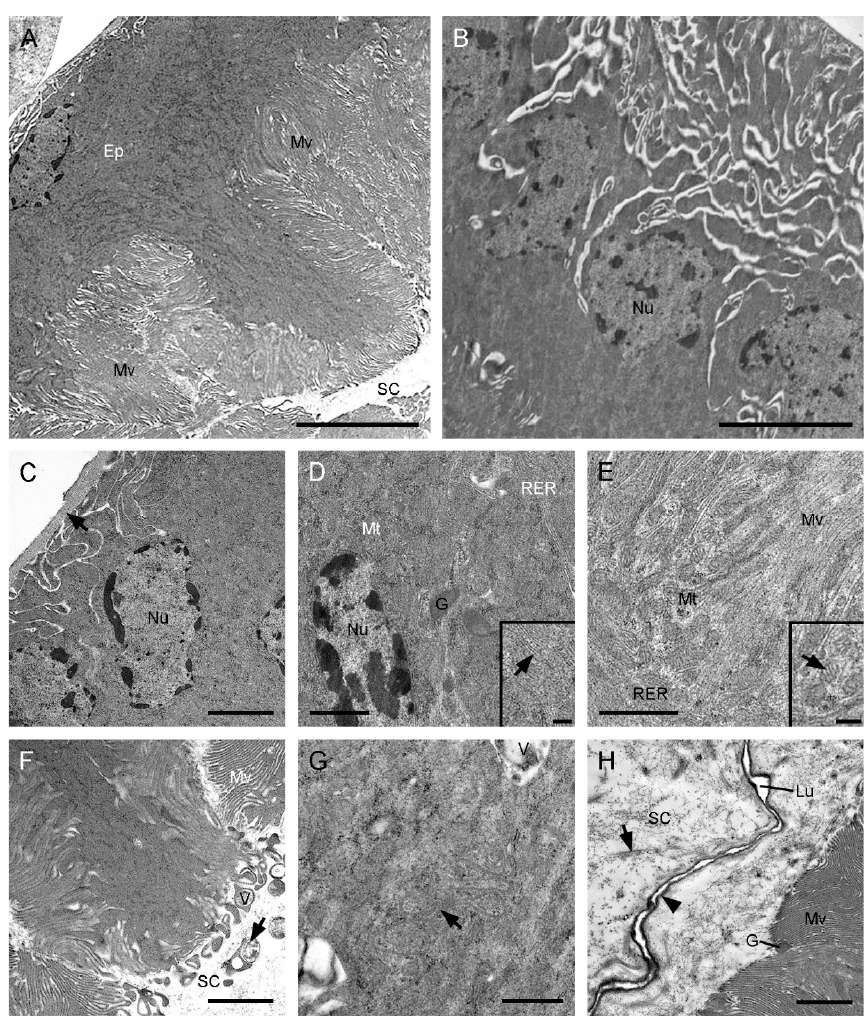
Figure 3. Median duct of ejaculatory duct of Cerapanorpa nanwutaina , cross-sections, TEM. ( A ) Epithelium and subcuticular cavity. ( B ) Basal region of the epithelium. ( C ) Nuclei in the basal region of the epithelium. Arrow points to the basal lamina. ( D ) Organelles and granules in medial cytoplasm. Inset shows the magnification of rough endoplasmic reticulum (arrow). ( E ) Basal part of microvilli with mitochondria and rough endoplasmic reticulum. Inset shows the magnification of mitochondrion (arrow). ( F ) Apical region of the epithelium, showing the microvilli and secretory fiber-bounded vesicle. Arrow points to the vesicle budding off into the subcuticular cavity. ( G ) Infolding (arrow) of the plasma membrane. ( H ) Subcuticular cavity and lumen. Arrow shows the electron-dense granule. Arrowhead points to the inner cuticle. Ep, epithelium; G, granule; Lu, lumen; Mt, mitochondrion; Mv, microvillus; Nu, nucleus; RER, rough endoplasmic reticulum; SC, subcuticular cavity; V, vesicle. Scale bars: ( A , B ) = 5 µ m; ( C , F , H ) = 2 µ m; ( D , E , G ) = 1 µ m; insets = 0.25 µ